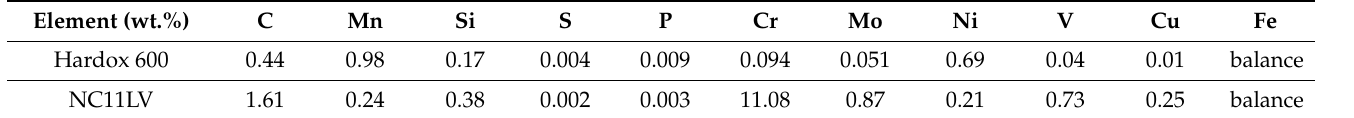
Table 1. Chemical composition of examined